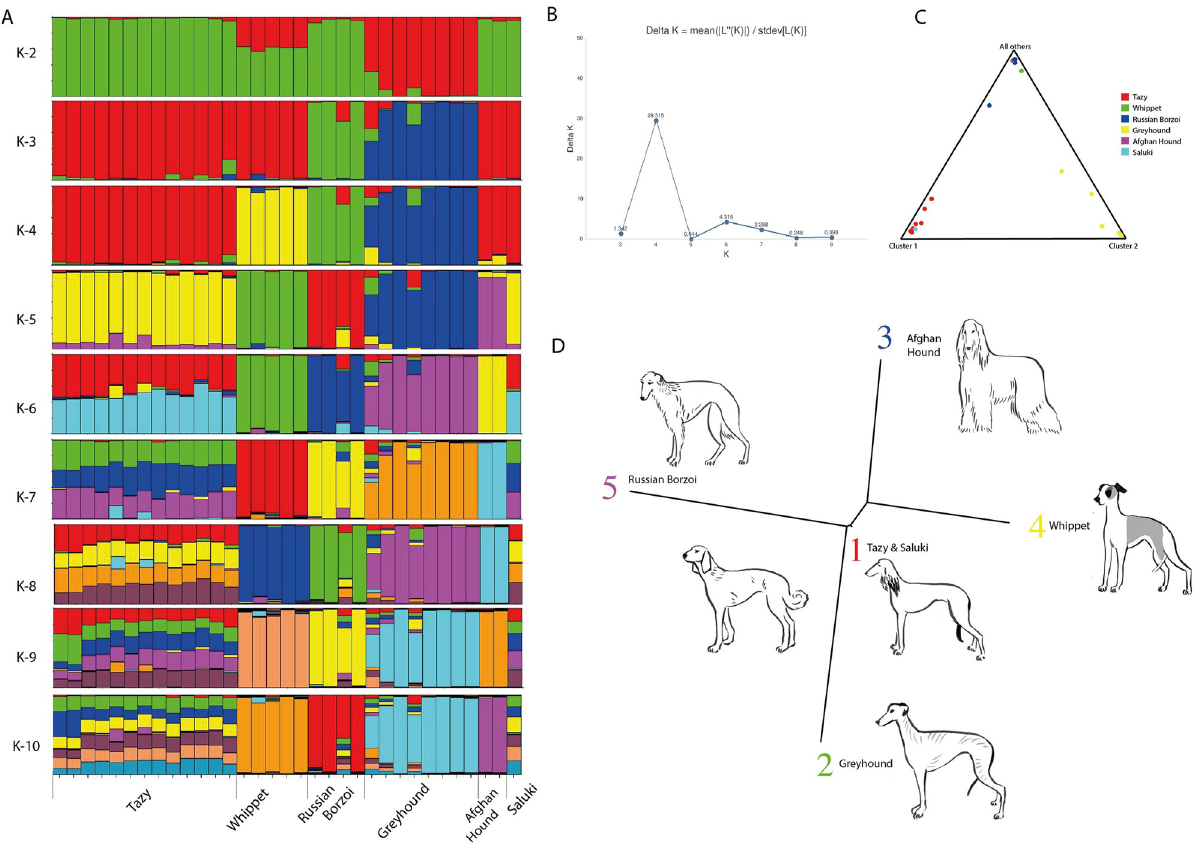
Fig 3. Genetic structure of sighthounds breeds. A—Bar plot. Bayesian clustering on the STR dataset of six sighthounds dogs performed with STRUCTURE v2.3.4 for a priori distinct number of K = 2–10; B—Delta K results; C—triange plot showing distribution of six breeds of sighthound in five clusters; D—tree plot representing the genetic distance between the STRUCTURE clusters. Canine images not drawn to scale. Reprinted from https://drive.google.com/drive/folders/1hFzoHRWnQ7-eNeKDZKwBy_nLaUs3bTJY?usp=share_link] under a CC BY license, with permission from Anna Molodykh, original copyright 2022.